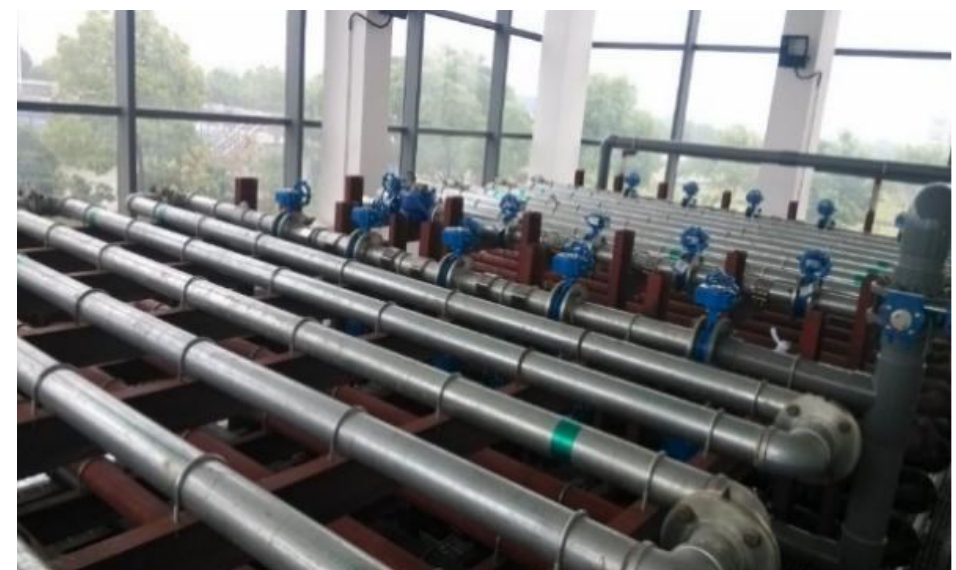
Figure 1. The simulated drinking water distribution system.